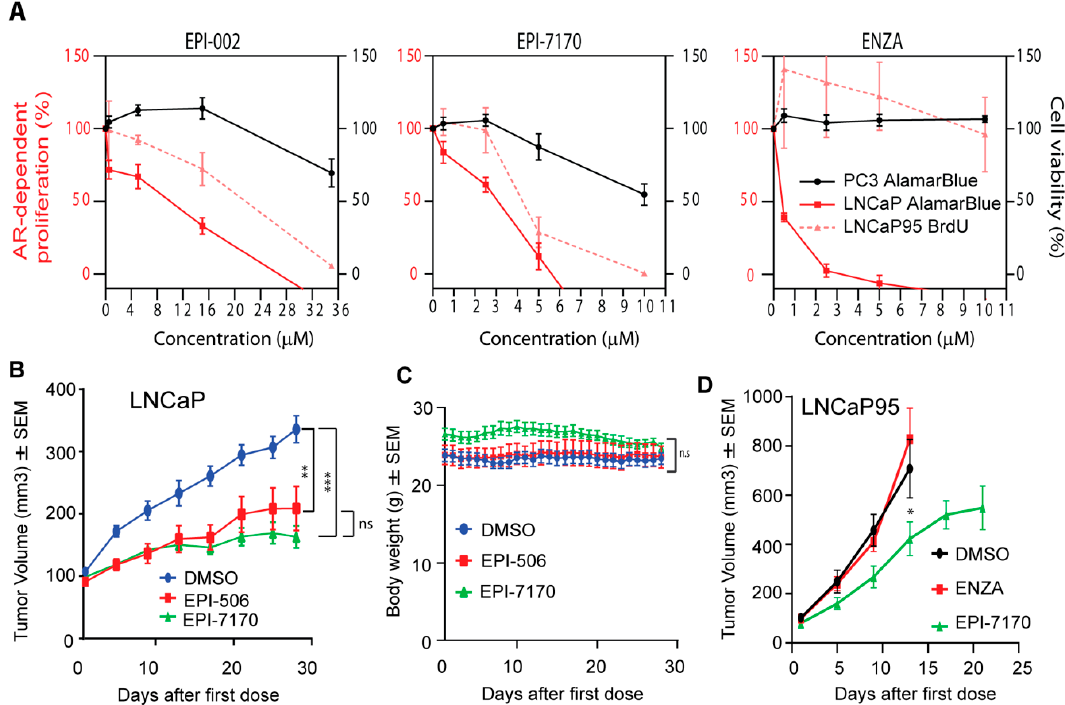
Figure 2. Ralaniten compounds specifically inhibit AR-dependent proliferation and tumor growth. ( A ) Androgen-induced proliferation of LNCaP cells (full-length AR), AR-V7-driven proliferation of